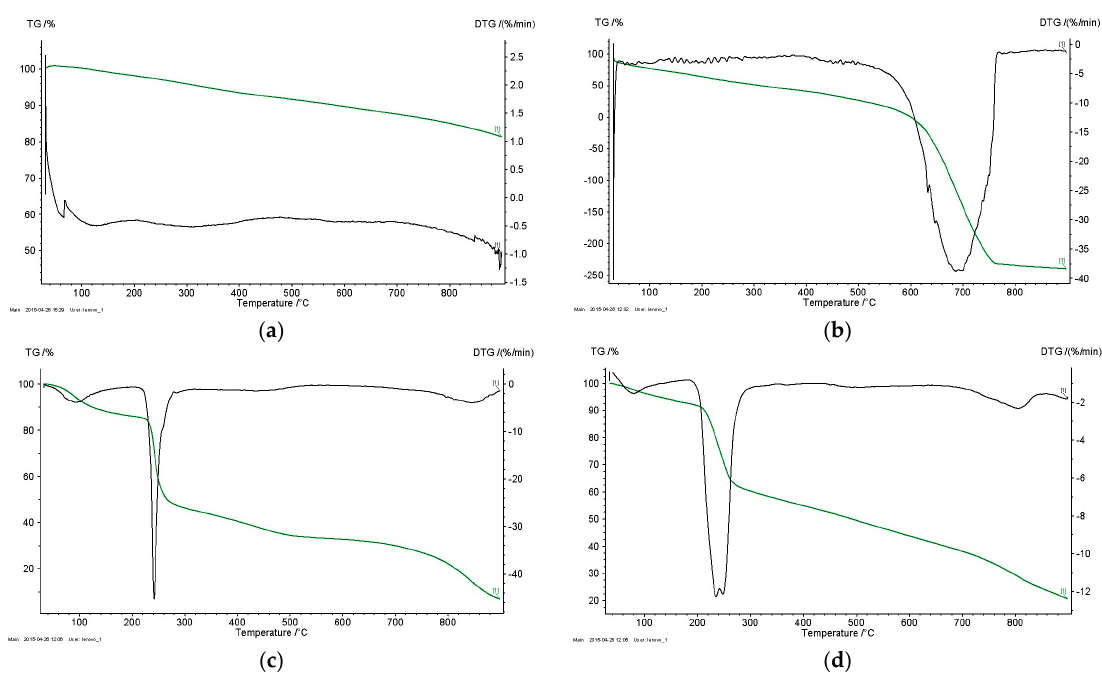
Figure 1. Thermogravimetric analysis (TGA) thermogram and its first derivative (DTG) of: ( a ) as-received CNTs, ( b ) functional CNTs, ( c ) sodium alginate, and ( d ) functional CNT-sodium alginate conjugate (% Functional CNTs = 17).